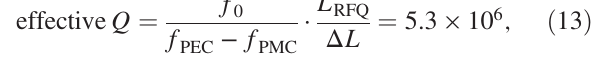
− f and associ- PEC PMC